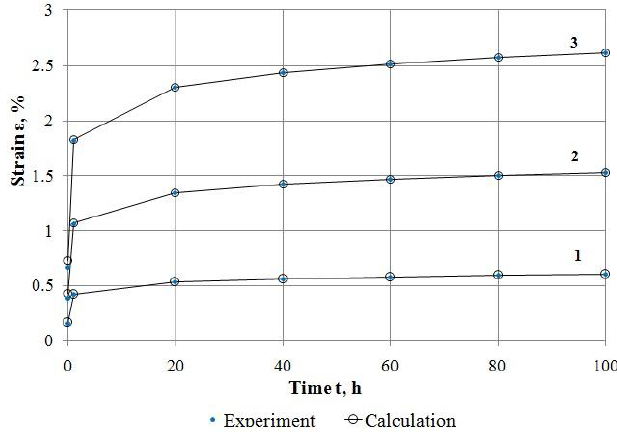
Figure 4. Creep curves of material Nylon 6 at various stresses: 1–5 MPa; 2–10 MPa; 3–15 MPa.